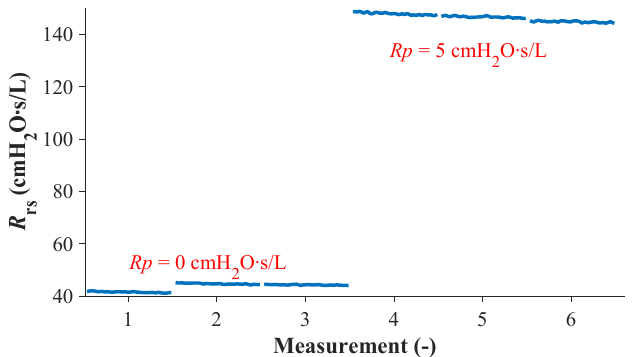
Figure 2. The computed R rs during ventilation of the respiratory system model without an added resistor (measurement sections 1, 2, and 3) and with added resistor Rp (measurement sections 4, 5, and 6). To investigate the effect of compliance on the measured resistance of the respiratory system, three glass demijohns with different compliance (37, 24, and 17 mL/cmH 2 O) were ventilated. Negligible change in R rs signal amplitude during measurement and a small change in R rs when compliance changed contrast with a large change in R rs when the resistance increased. Table 1. Values of computed R rs (cmH 2 O ∙ s/L) in both phases of the experiment (without/with the resistor) for glass demijohns of three different compliances C . R rs with No Resistor